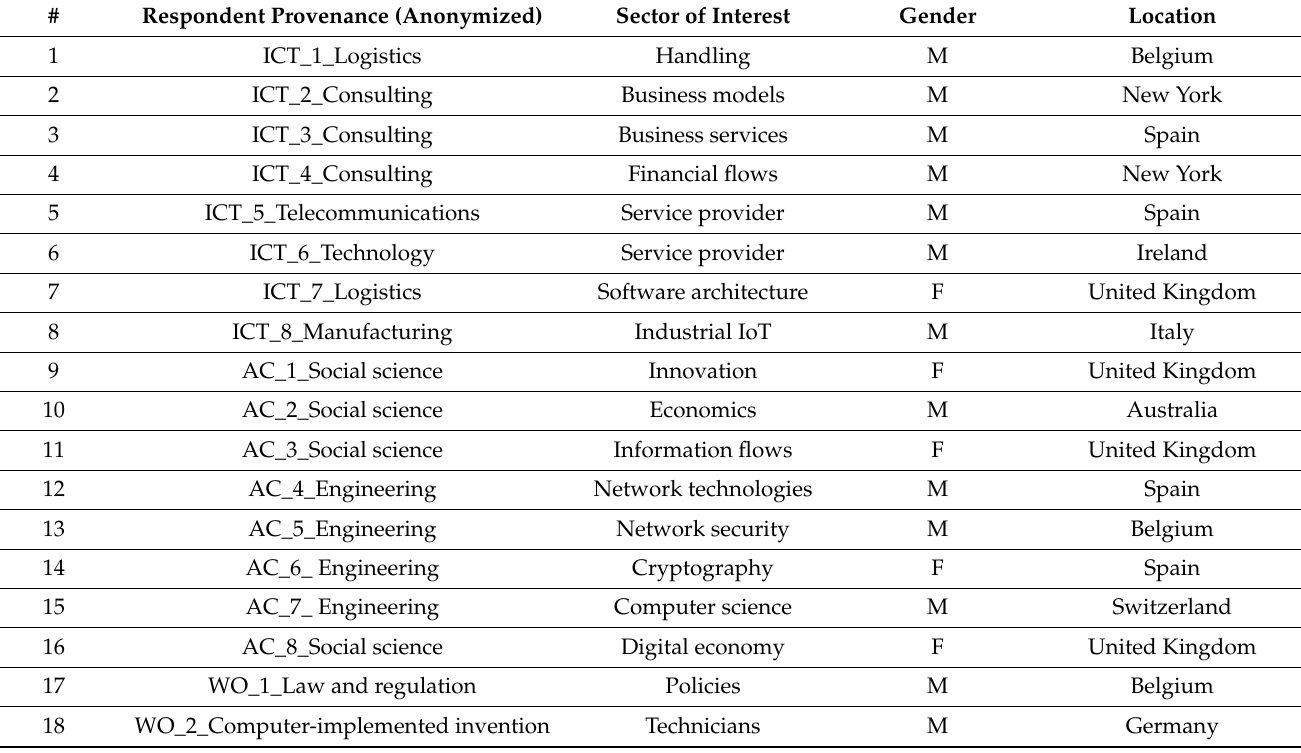
Table 3. Pool of experts